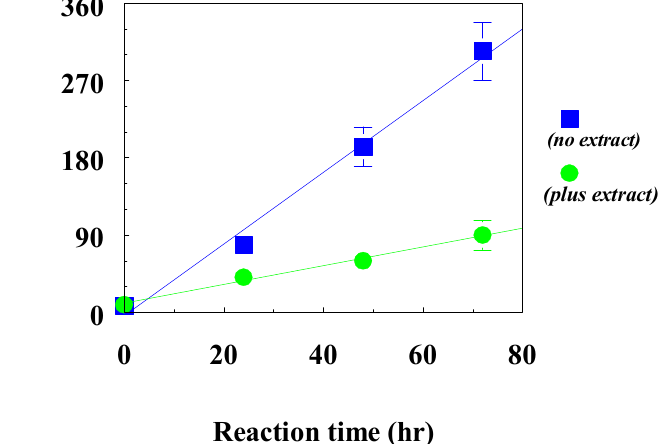
Figure 5. Influence of beetle extract on the rate of fructosylation of bovine serum albumin: no extract, control; plus extract, added 0.36 mg/mL dry weight of beetle extract. Incubation was carried out at a temperature of 37 °C in the dark and with constant stirring.